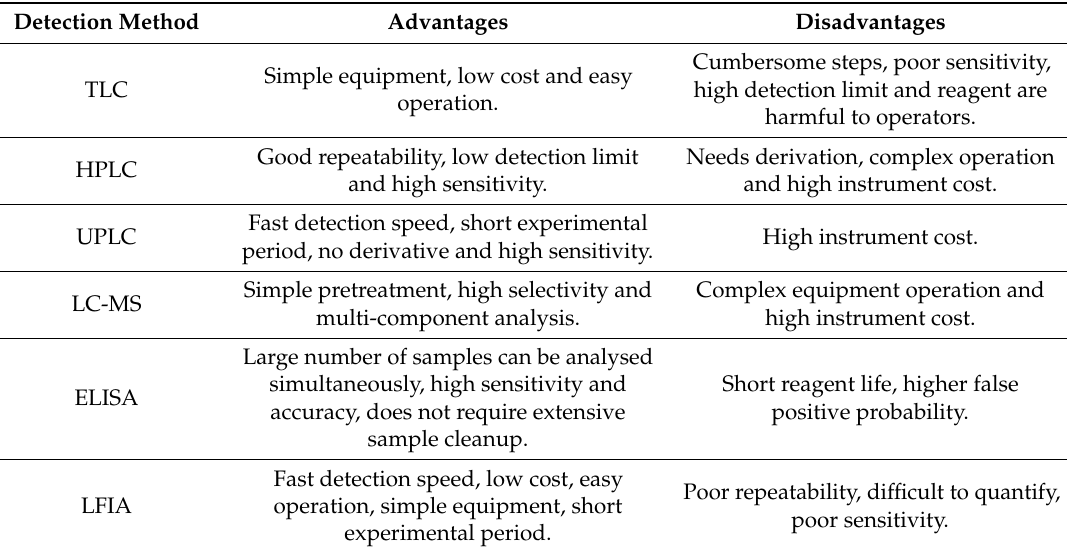
Table 1. The common detection methods of